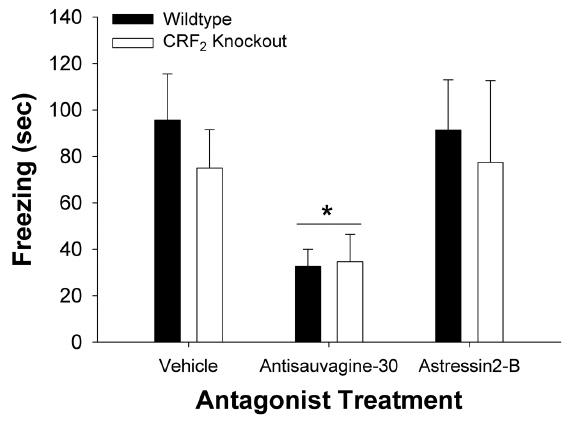
Figure 1. Effects of antisauvagine-30, astressin 2 -B and CRF 2 genotype on shock-induced freezing. The data are expressed as M 6 SEM. Antisauvagine-30 (i.c.v., 3 nmol) significantly and equally reduced the duration of shock-induced freezing in both wildtype and CRF 2 knockout mice. In contrast, the same dose of astressin 2 B, a selective CRF 2 antagonist, and CRF 2 null genotype did not alter shock- induced freezing ( n =6–9/group). * p , 0.05, differs from vehicle and astressin 2 -B-treated mice (Fisher’s protected least significant difference